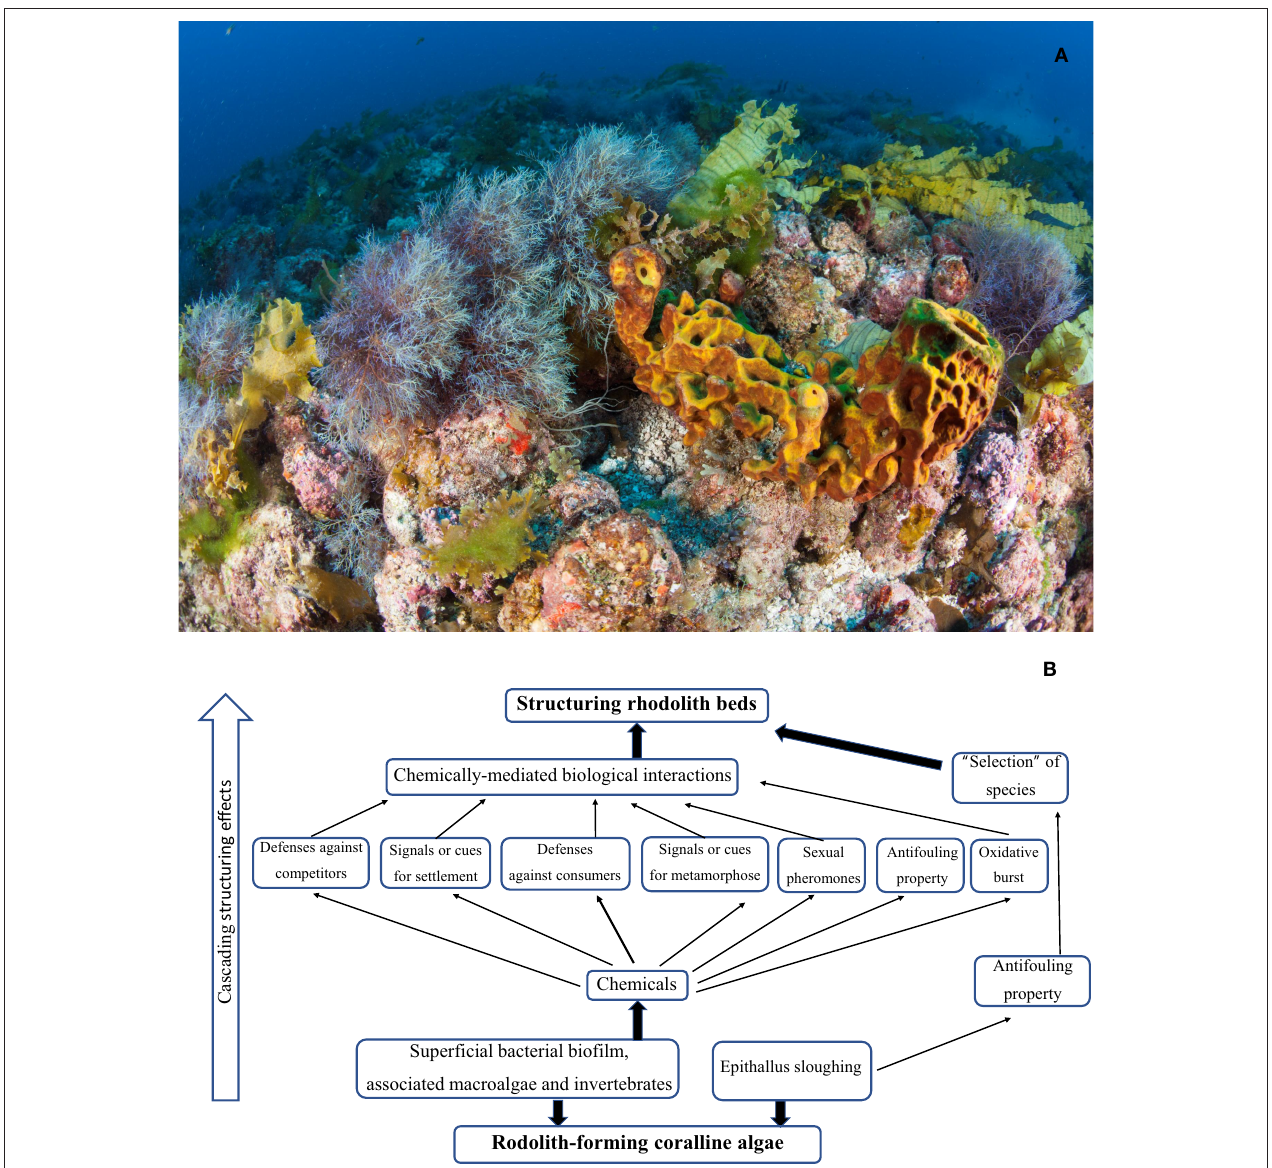
FIGURE 1 | (A) A diverse community of macroalgae and invertebrates inhabiting a rhodolith bed at the Abrolhos Bank, Brazil. Photo by Áthila Bertoncini/Rede Abrolhos. (B) Possible mediation among organisms in rhodolith beds that may be key for its community structuring.